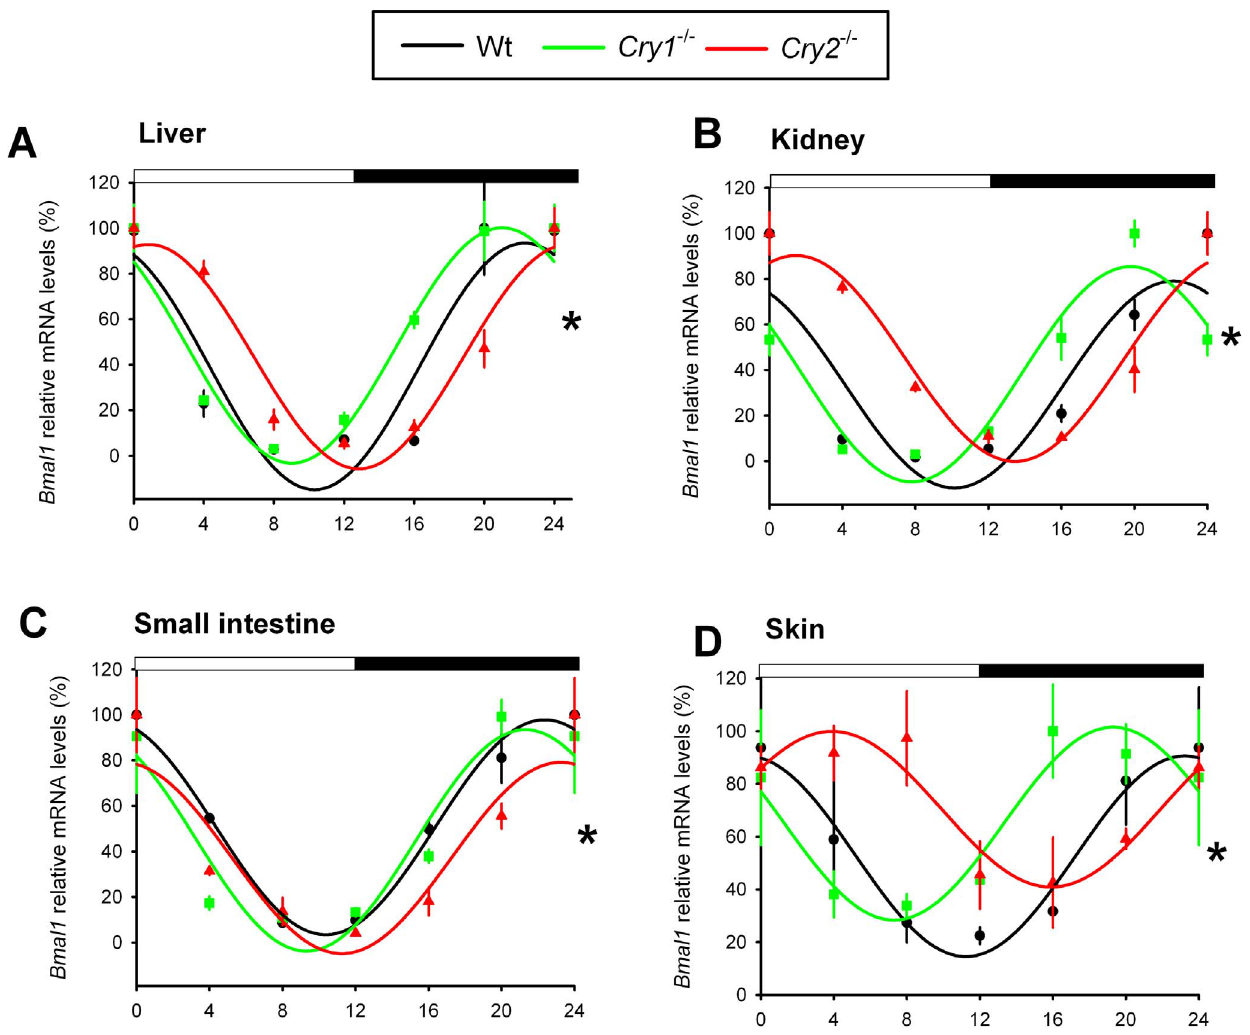
Figure 3. Bmal1 expression profiles in peripheral tissues of light-entrained Cry1 -/- and Cry2 -/- mice. Relative mRNA expression profiles of Bmal1 in the liver (A), kidney (B), small intestine (C), and skin (D) of light entrained (LD 12:12) wild type (black), Cry1 -/- (green), and Cry2 -/- (red) mice, as measured by RT-qPCR. For each genotype, mRNA levels (mean 6 s.e.m) are expressed relative to the peak of expression (set at 100%) and fitted with a wave curve. The two-way ANOVA test revealed a significant effect of genotype and time interaction (*p , 0.05). Data at ZT0 and ZT24 are double- plotted for easier visualization of daily expression. The bar above panels indicates time of light on and off.